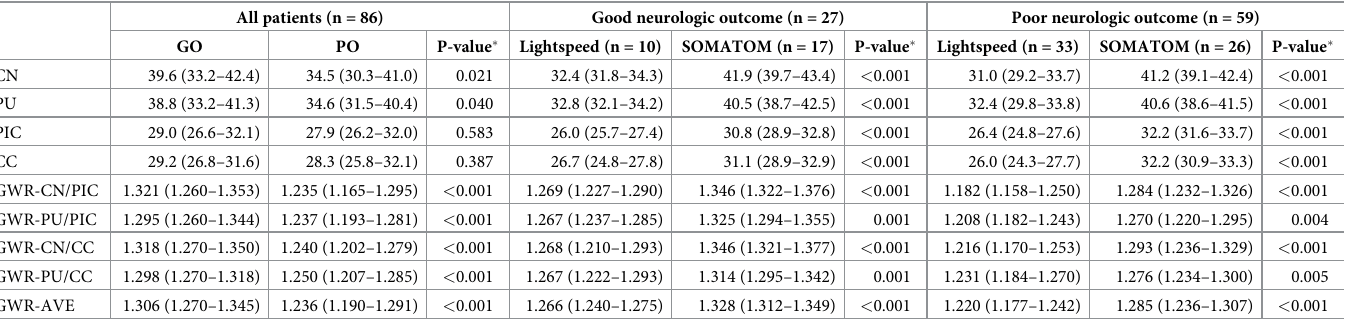
Table 3. Differences in the neurological outcome and GWR for each CT scanner.